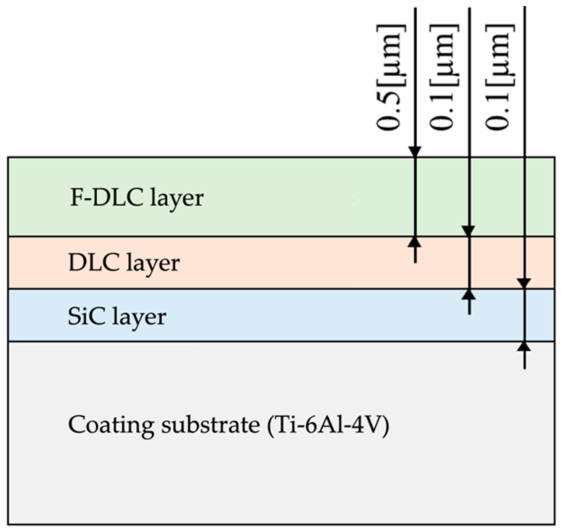
Figure 1. Coating thickness and